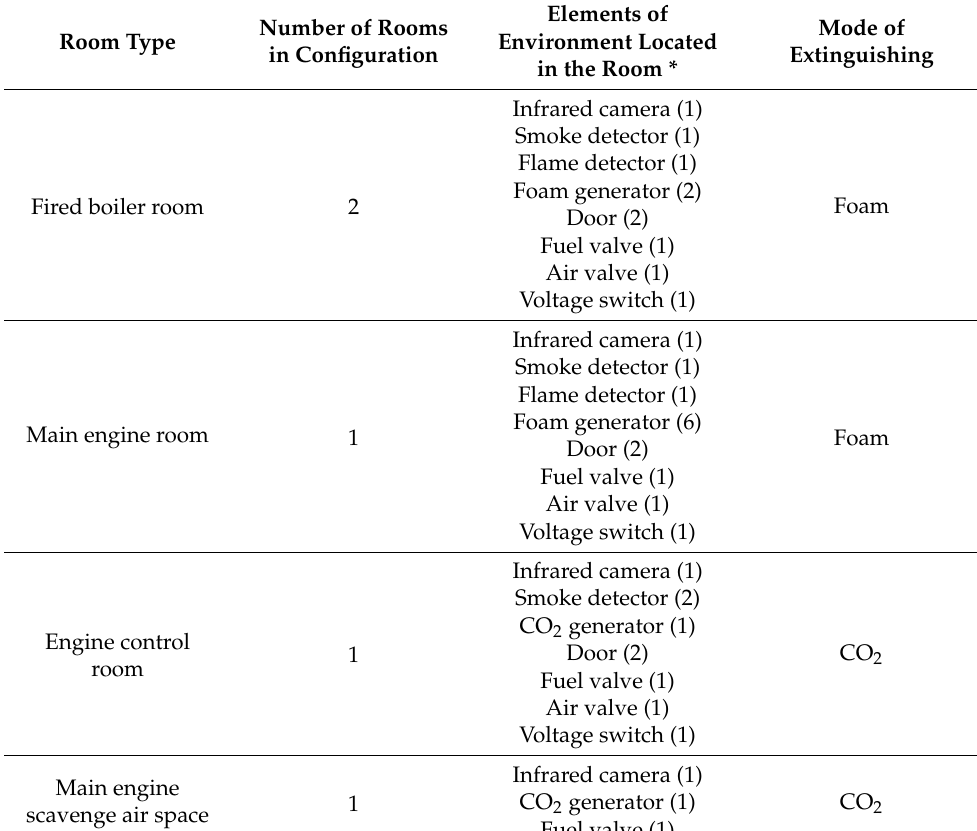
Table 2. Part of the configuration of environment.